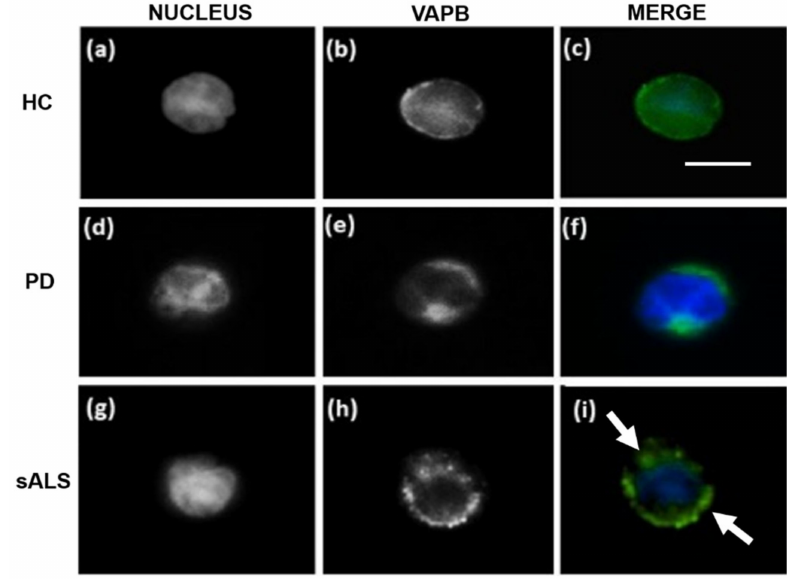
Figure 3. Representative confocal monochromatic nucleus ( a,d,g ), VAPB ( b,e,h ), and merge ( c,f,i ) images of immunofluorescence performed with an antihuman VAPB polyclonal antibody in PBMCs of HCs, PD patients, and sALS patients. VAPB is represented in green, and the nuclei are in blue. ( i ) The merge image shows the presence of VAPB ER-aggregates in sALS patients that is clearly di ff erent from those obtained in PD patients ( f ) and HCs ( c ). The arrows indicate VAPB ER-aggregates. Scale bars: 20 µ m. Each sample were analyzed in 20 fields. For each subject, the number of lymphocytes showing VAPB aggregates was divided by the original total number of isolated cells (2 × 10 4